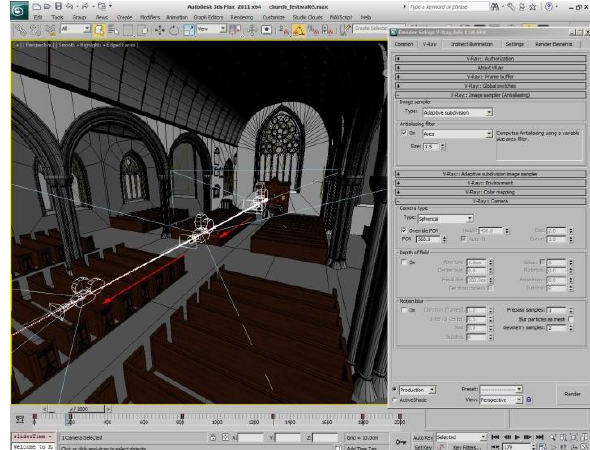
Figure 14 The generation of 360º video in 3ds Max